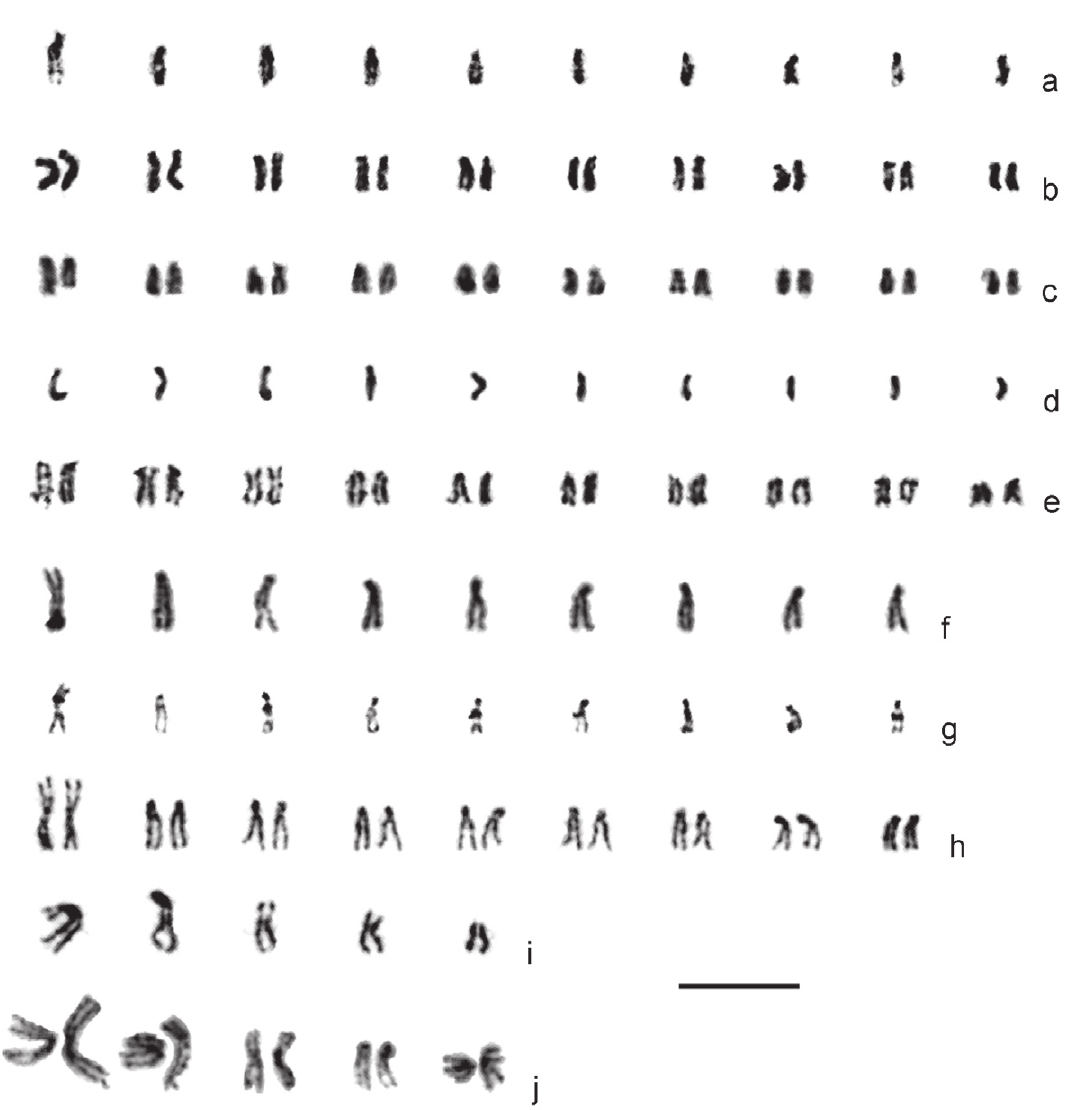
Fig. 1, a-j. Chromosomes of Metaphycus species. a - M. fl avus , haploid karyogram. b - M. fl avus , diploid karyogram, fi rst pair of chromosomes homomorphic. c - ditto, fi rst pair of chromosomes heteromorphic. d - M. luteolus , haploid karyogram. e - M. luteolus , diploid karyogram. f - M. angustifrons , haploid karyogram, routine chromosome staining. g - ditto, C-banding. h - M. angustifrons , diploid karyogram. i - M. stanleyi , haploid karyo- gram. j - M. stanleyi , diploid karyogram. Bar = 10